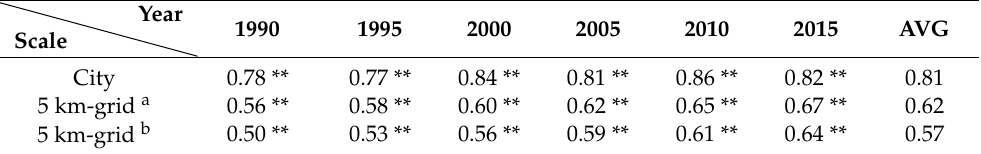
Table 1. The correlation between LV and PB at the municipal scale and the 5 km-grid scale in the YRD from 1990 to